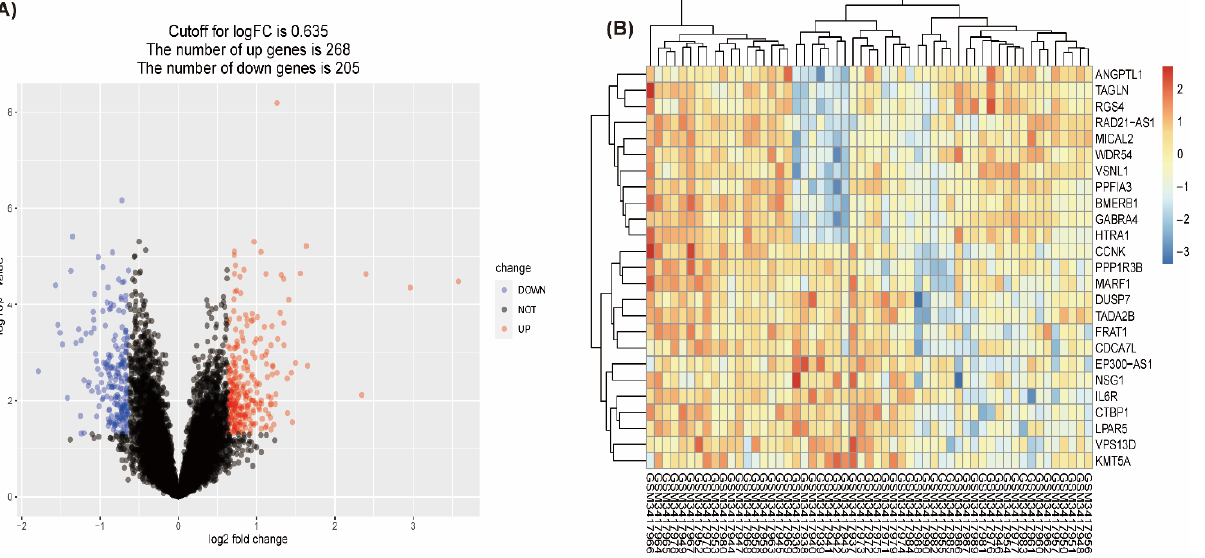
Figure 2. Volcano plot and heatmap for differentially expressed genes identified in the GSE120895 dataset; red indicates upregulated genes, and blue indicates downregulated genes. ( A ) The volcano plot shows up- and downregulated genes. ( B ) The heatmap shows the expression of the 25 most differentiated genes in individuals.